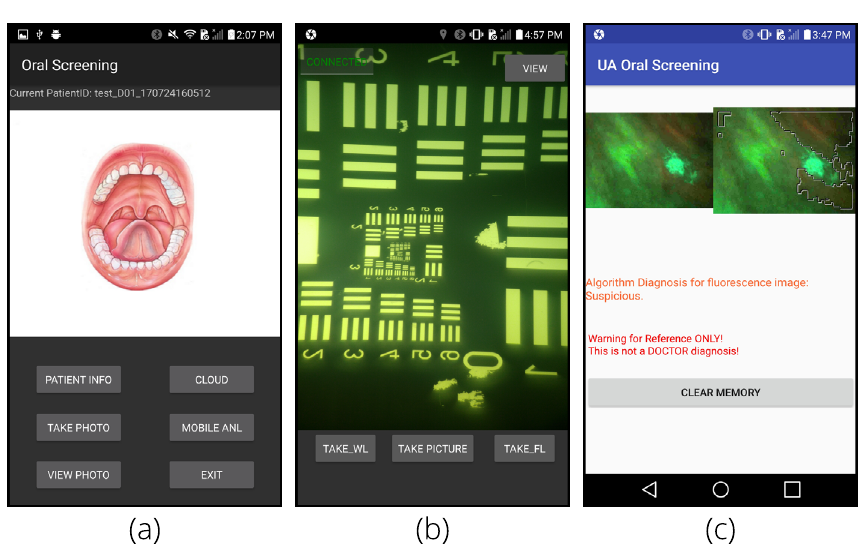
Fig 6. Screenshots of the custom Android application. (a) shows the main menu of the app where buttons allow for navigation to image capture, image viewing, image upload to the cloud, and mobile analysis. (b) shows the image capture interface for both WLI (using the ‘TAKE_WL’ button) and AFI (using the ‘TAKE_FL’ button) individually or sequentially using the ‘TAKE PICTURE’ button. (c) shows a sample result for on-phone image processing of AFI